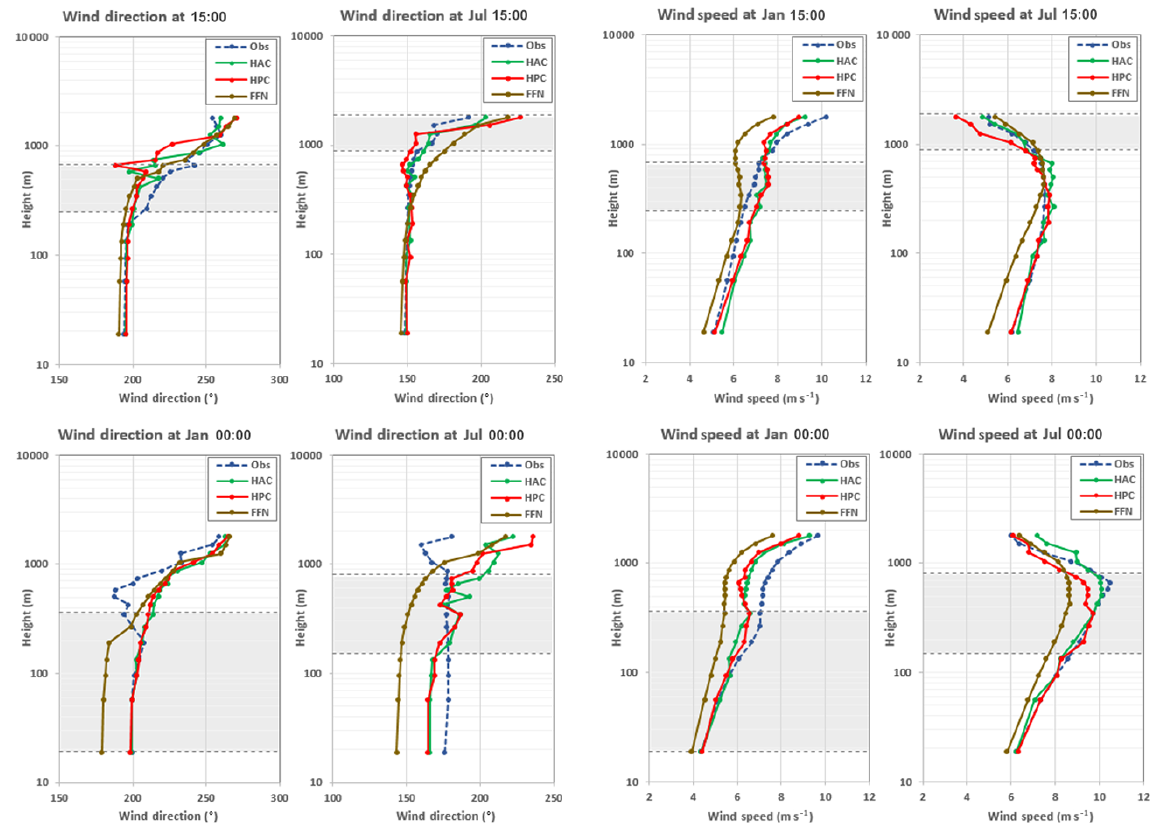
Figure 4. Same as Fig. 2 but for wind direction and wind